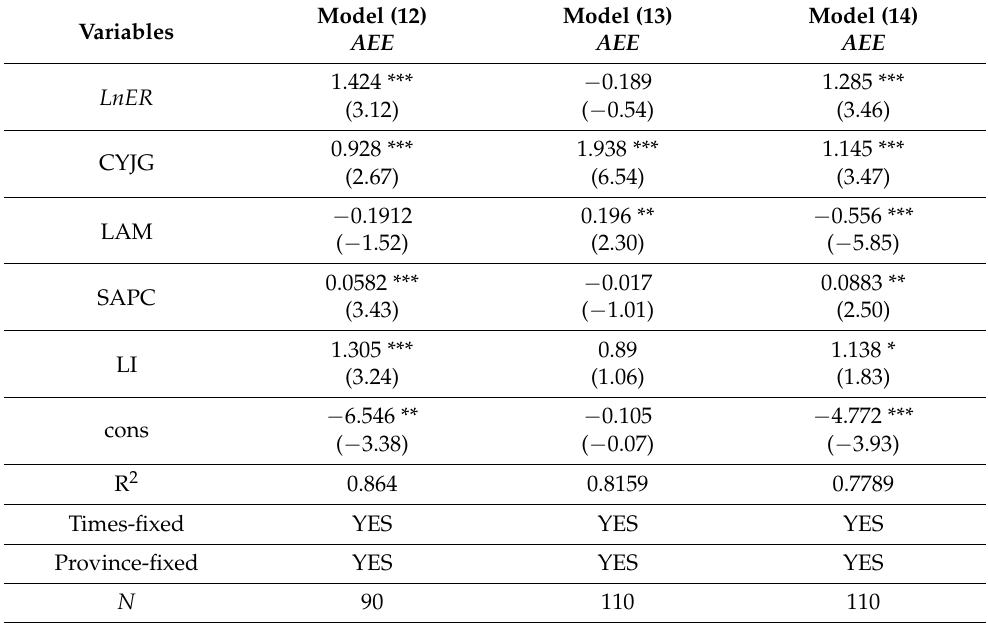
Table 6. Analysis of heterogeneity regression